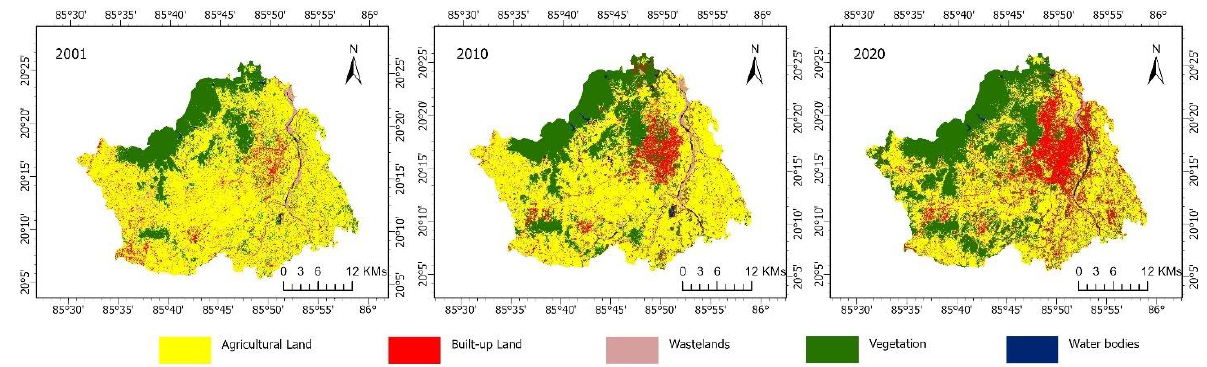
Figure 2. Land use / Land cover classification pattern in 2001, 2010 and